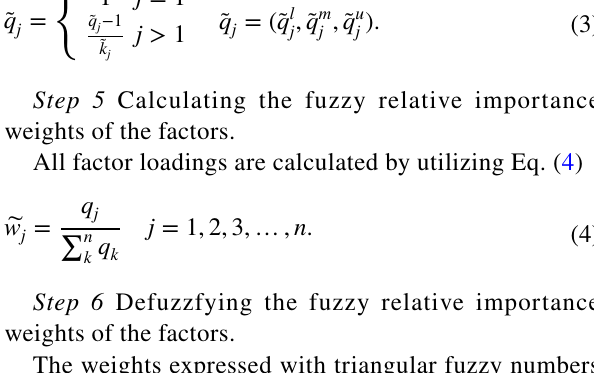
Fig. 2 Illustration of mental and physical workload as forces